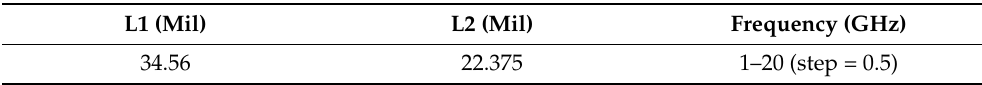
Table 6. Test data of rectangular